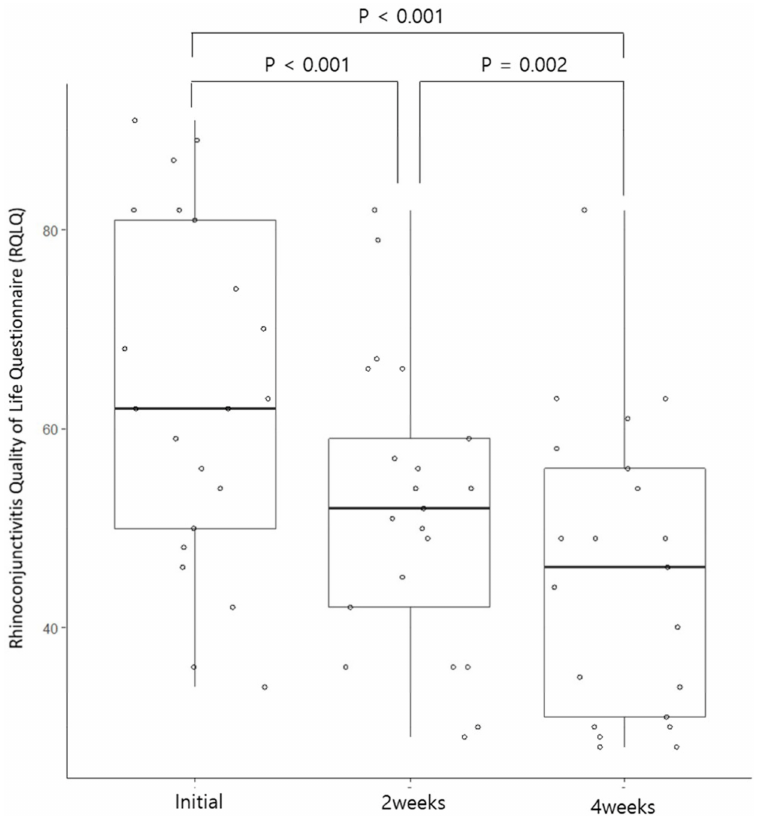
Figure 2. Changes in the Rhinoconjuntivitis Quality of Life Questionnaire score at 2 and 4 weeks before and after phototherapy among patients with allergic